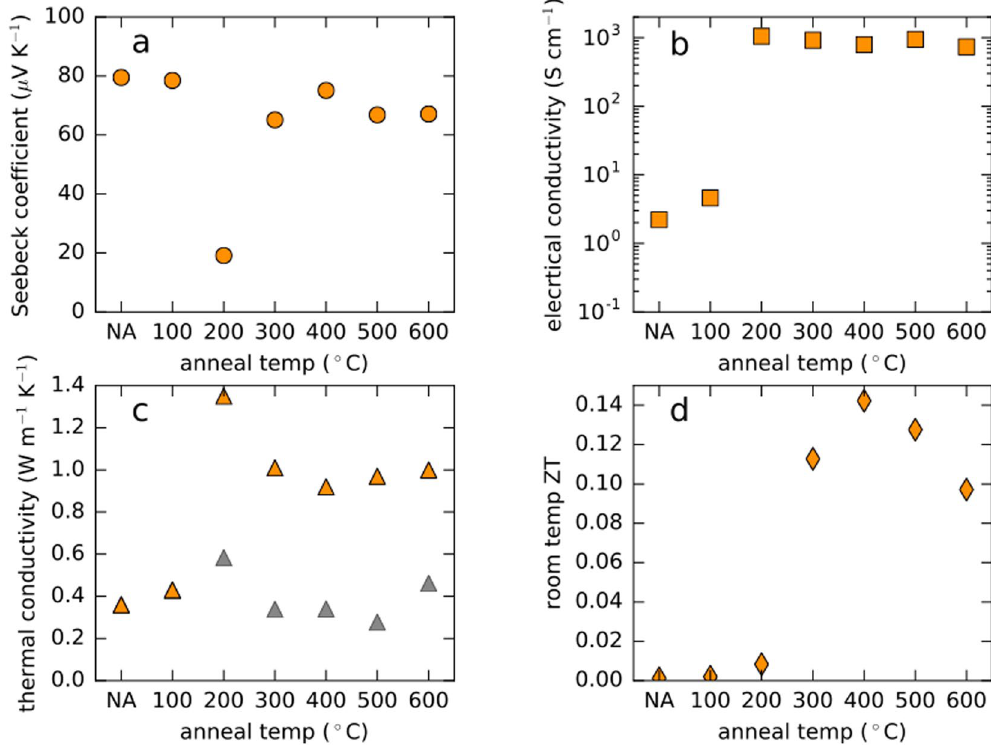
Figure 3. Thermoelectric Performance as a Function of Annealing Temperature. ( a–d ) Room temperature values for Seebeck coefficient, in-plane electrical conductivity, cross-plane thermal conductivity, and ZT , respectively, plotted as functions of annealing temperature (“NA” stands for “not annealed”). The gray symbols in panel ( c ) are estimates of the lattice thermal conductivity, which are computed using the Wiedemann-Franz Law, κ lattice = κ total − σ e LT , where κ total = κ electronic + κ lattice is the total thermal conductivity measured by TDTR, σ Supplementary Figure